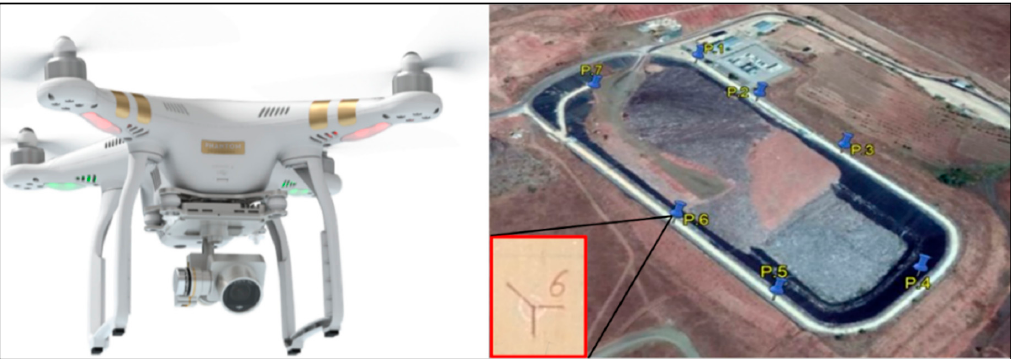
Figure 3. The unmanned aerial vehicle (UAV) employed ( left ) and the distribution of GCPs on the road surrounding the landfill ( right ).